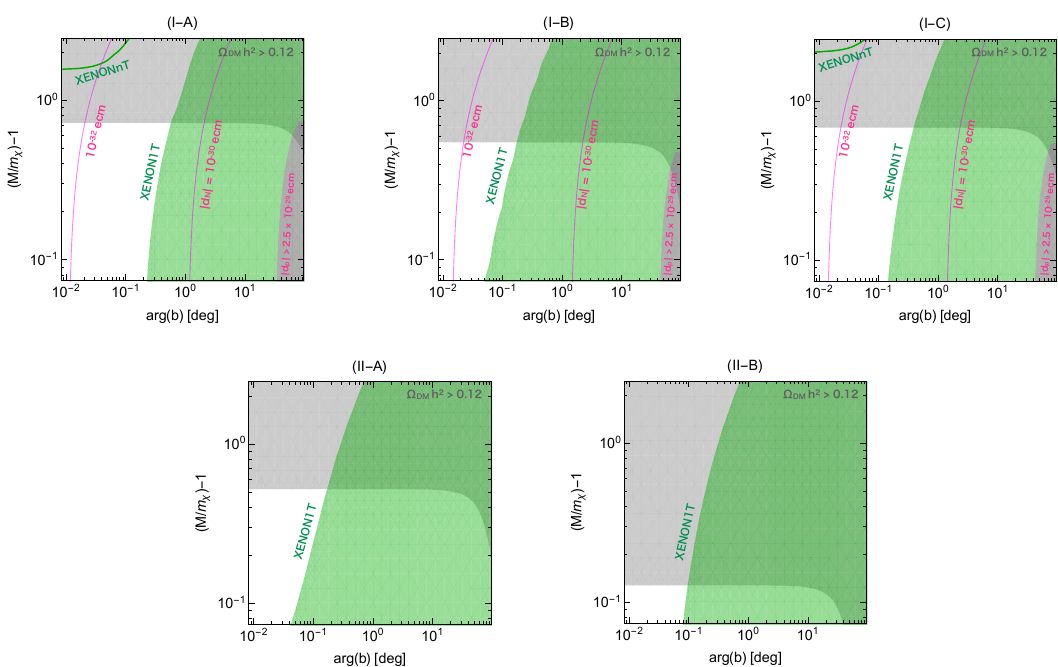
Figure 14 . Current limits provided by XENON1T [80] (green shaded area) and expected sensitivity of XENONnT [81] (green solid line) in the parameter space of each model. We also show the predicted values of the nucleon EDM in the magenta solid lines, as well as the expected reach provided by the future nucleon EDM search, 2 : 5 10 (cid:0) 29 e cm [87], in the magenta shaded d p j j (cid:21) (cid:2) (cid:1) region. The gray shaded area represents the region where the DM density exceeds the observed value: (cid:10) DM h 2 0 : 12. Here we take m = 3 TeV, 2 TeV, 2 TeV, 2 TeV, and 1.5 TeV in the cases (cid:31) (cid:21)